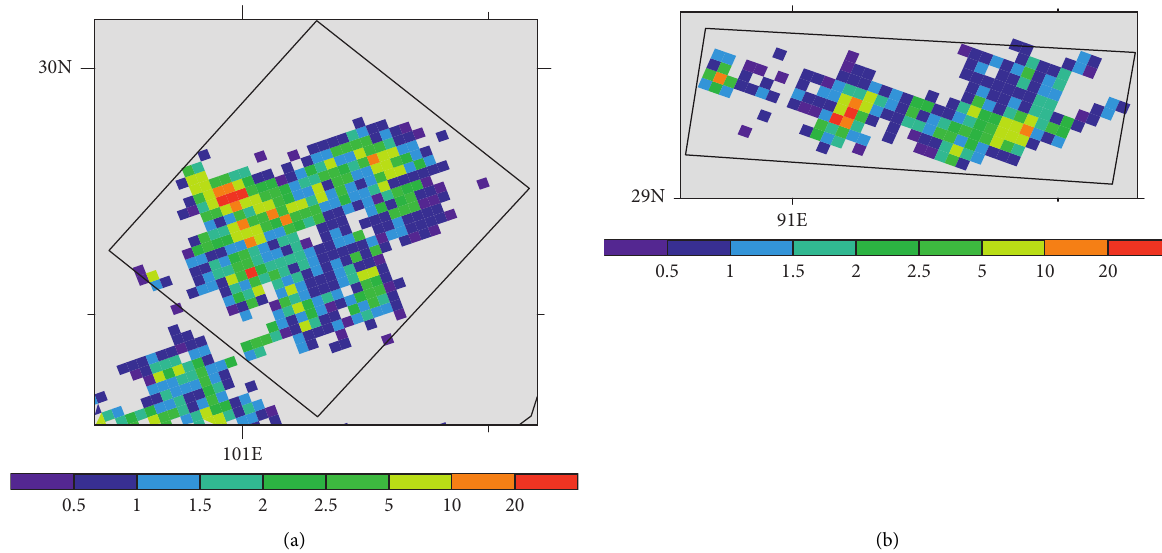
Figure 2: Near-surface rain rate of two precipitation clouds occurred on Tibetan Plateau ((a) 15 June 1998; (b) 7 August 1998) measured by